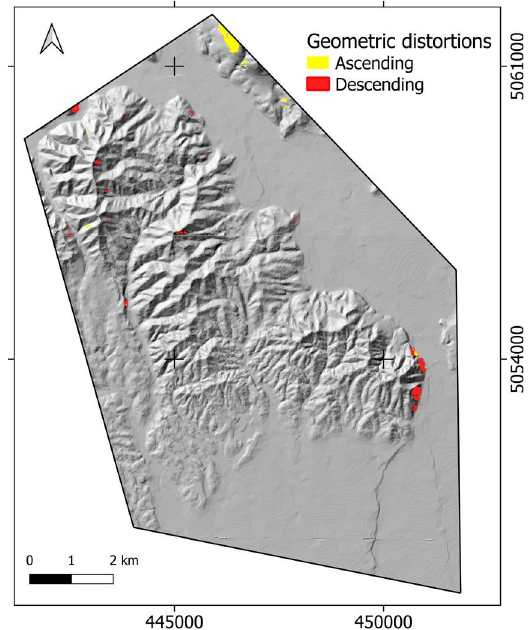
Figure 3 . Geometric distortions mapped by SNAP tool for ascending and descending nodes. Reference frame is WGS84 UTM 32N.